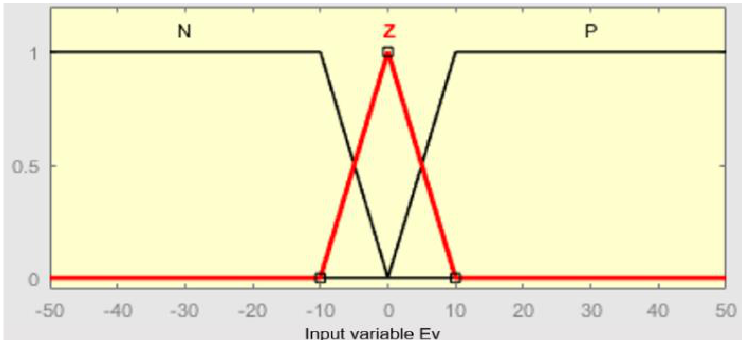
Figure 5. Linguistic variable E V (k).